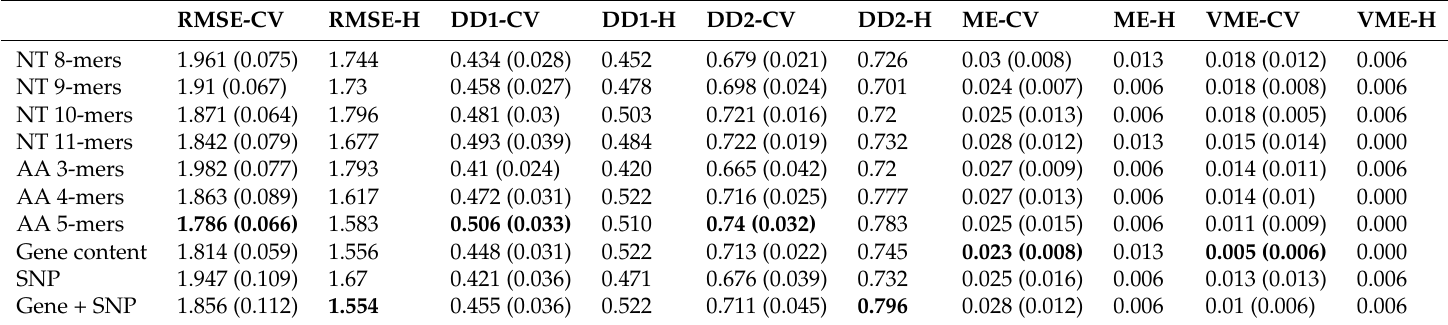
Table A46. K. pneumoniae